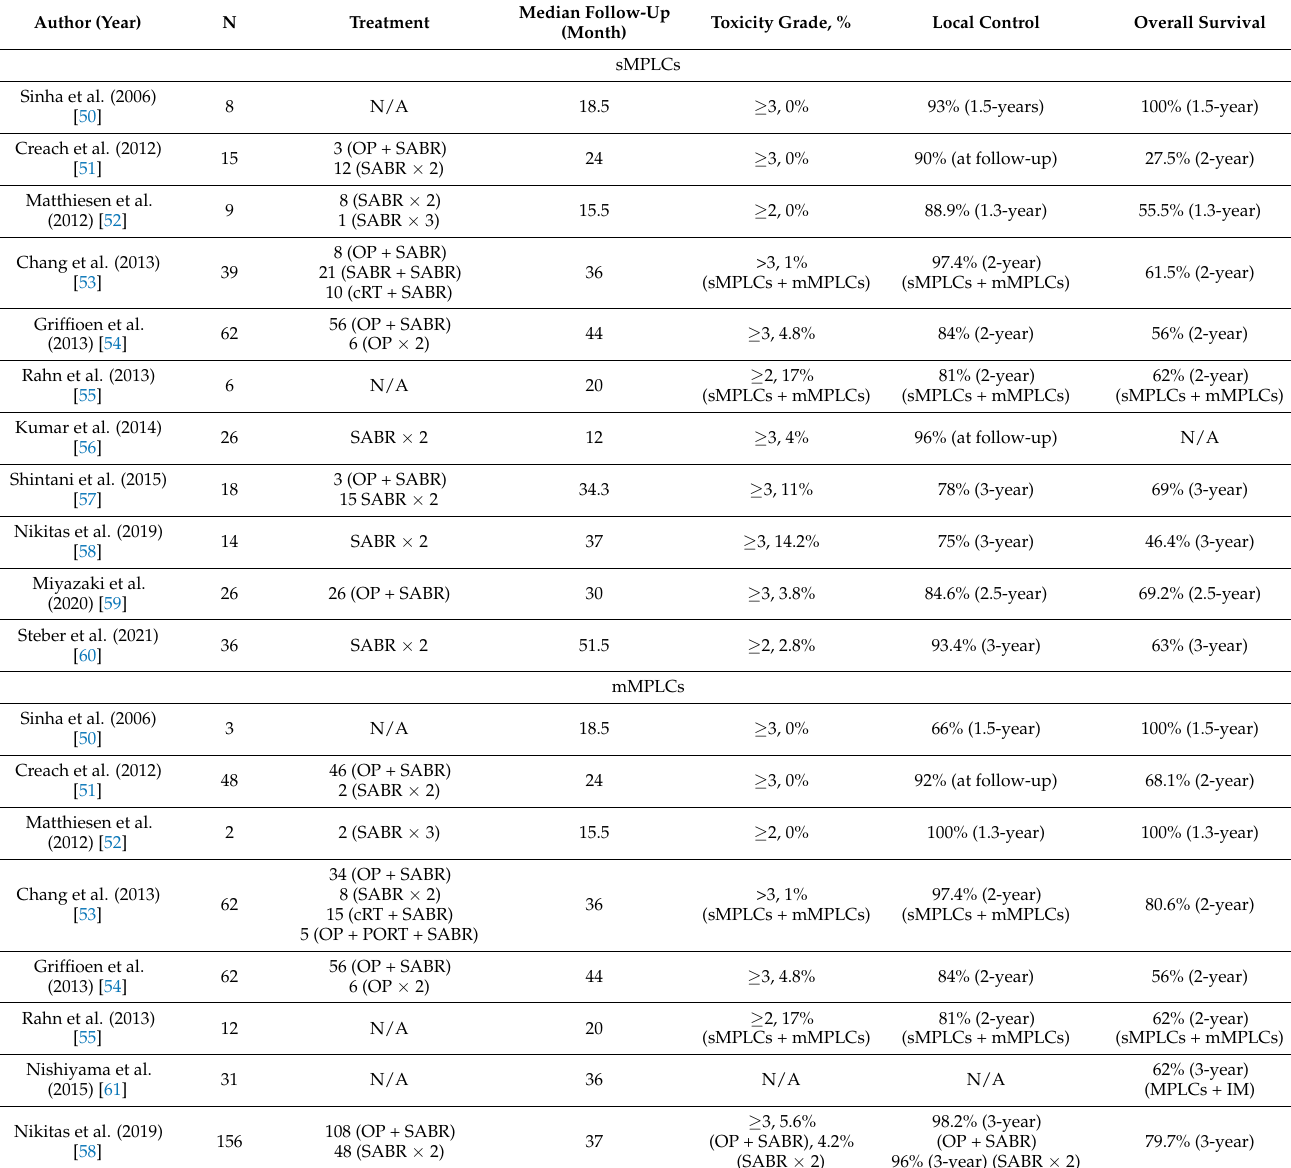
Table 2. Published series on the effect of SABR on sMPLC and